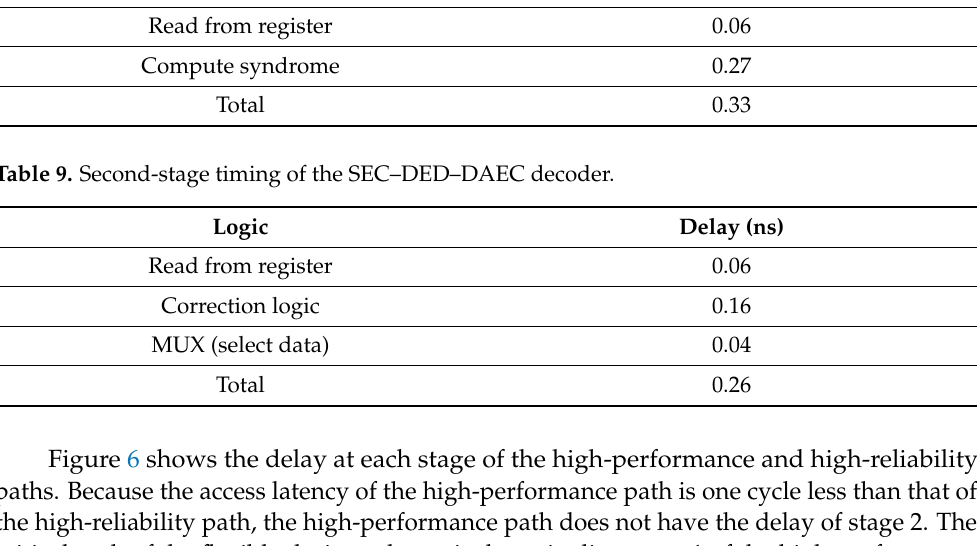
Table 8. First-stage timing of the SEC–DED–DAEC decoder.